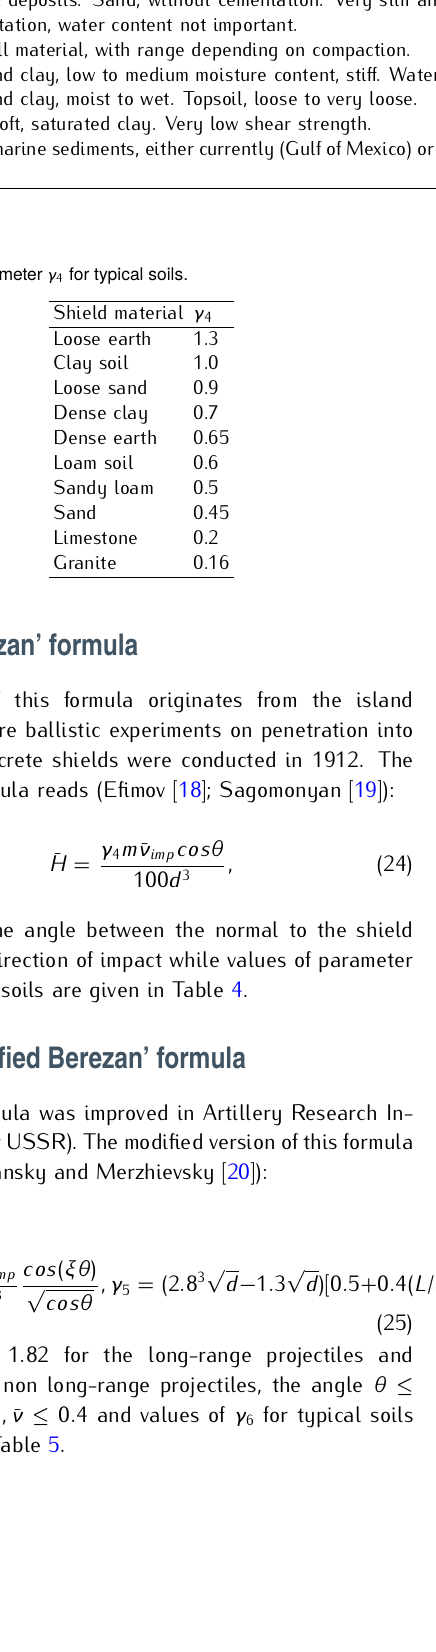
Table 3. Parameter for typical soils (Young [15]). Shield Description K s Dense, dry, cemented sand. Dry caliche. Massive gypsite and selenite deposits. 2 - 4 Gravel deposits. Sand, without cementation. Very stiff and dry clay. Moderately dense to loose sand, not cementation, water content not important. Soil fill material, with range depending on compaction.